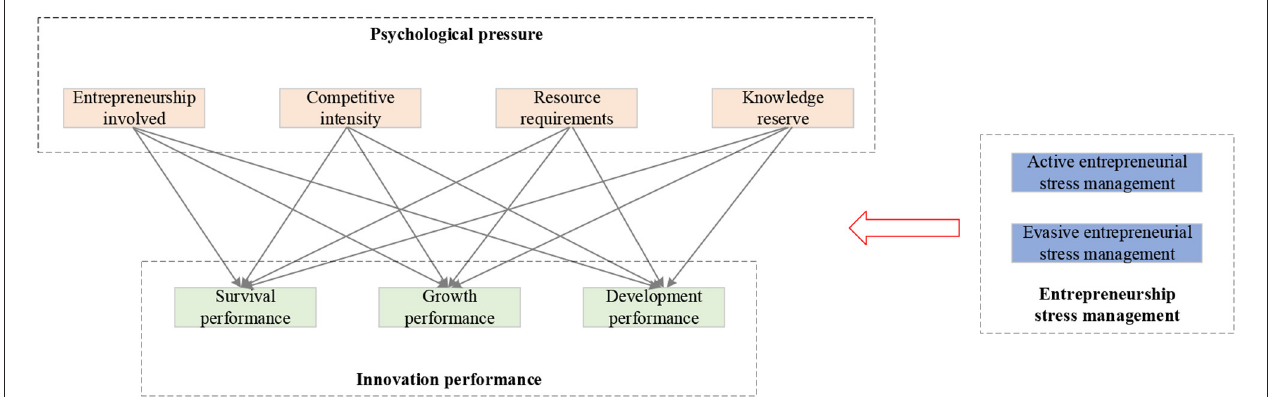
FIGURE 4 | The model of psychological stress and new venture performance of new venture